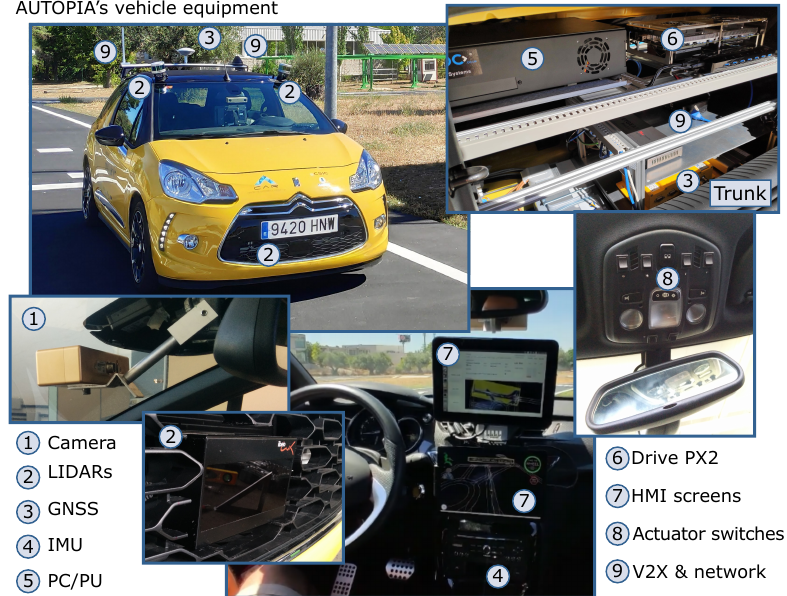
Figure 4. Automated vehicle for